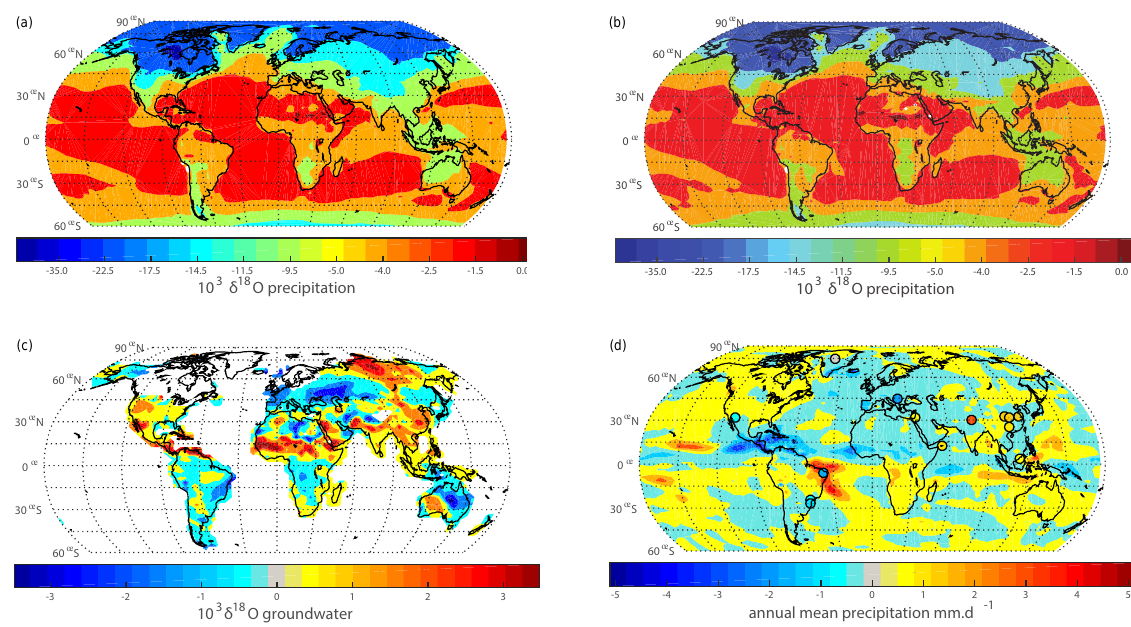
Figure 3. Amount-weighted annual-mean δ 18 O of precipitation for (a) LGM_ctrl and (b) HS_exp experiments obtained with LMDZ-iso. Note that the anomaly can be seen in Fig. 4a. (c) HS_exp–LGM_ctrl annual-mean anomaly of groundwater δ 18 O. Groundwater δ 18 O represents the isotopic value of the substrate water for photosynthesis (see text for details). (d) HS_exp–LGM_ctrl annual-mean anomaly of rainfall